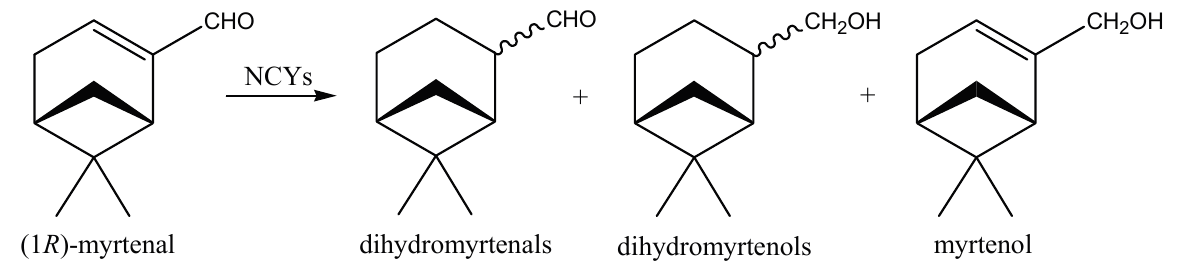
Figure 8. Bioconversion of (1 R )-myrtenal by whole-cells of